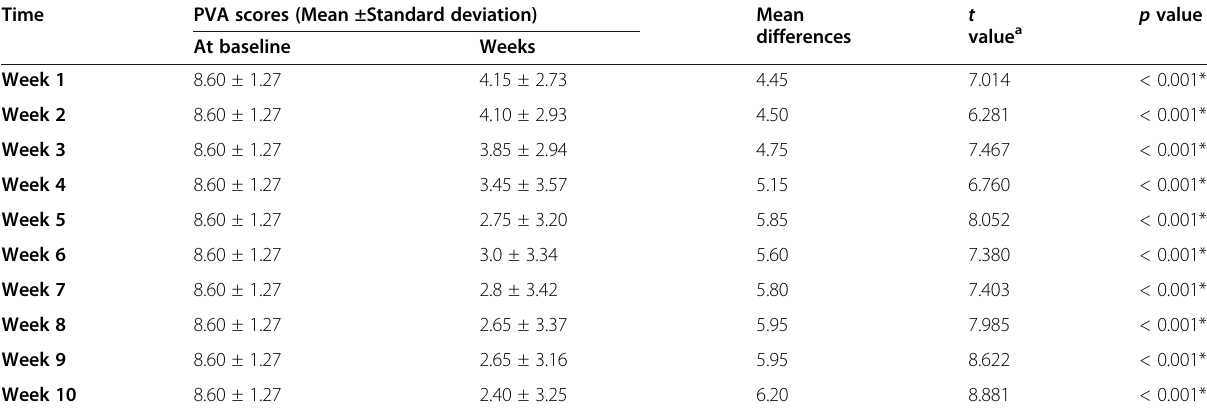
Table 4 The mean comparison of pain levels (post visual analogue scale scores) in males across 10 weeks compared with the baseline (after the intervention) Time PVA scores (Mean ±Standard deviation)